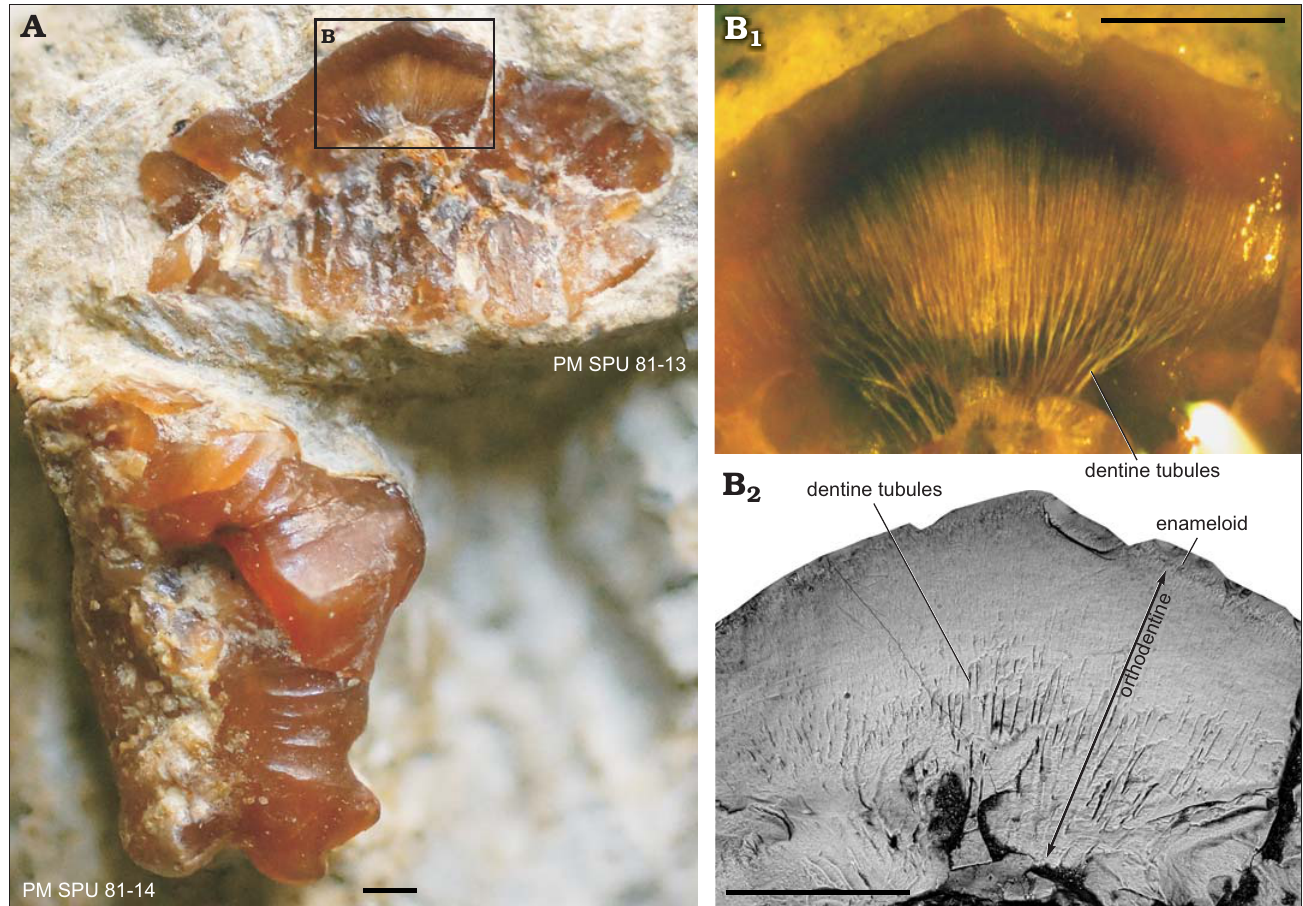
Fig. 4. Teeth of the euselachian shark Artiodus prominens Ivanov and Duffin gen. et sp. nov. from the Artinskian (Early Permian) of Krasnoufimskie Klyuchiki quarry (Middle Urals, Russia). A . PM SPU 81-13, tooth with broken crown in the longitudinal section in lingual view and PM SPU 81-14 in labial view. B . PM SPU 81-13, details of the crown; optical microscope photograph in aniseed oil (B 1 ) and SEM microphotograph (B 2 ). Scale bars 500 μ